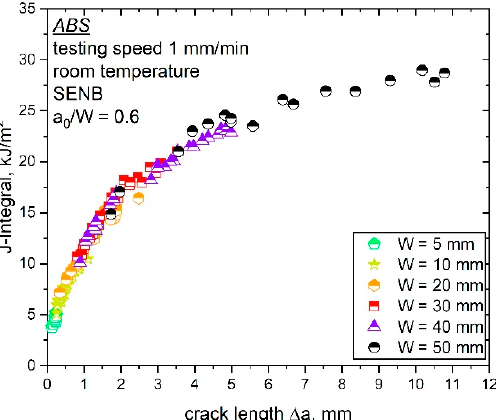
Figure 11. J–R curve for increasing specimen sizes (W is 5, 10, 20, 30, 40 and 50 mm) of ABS as de- termined following the ESIS TC 4 multispecimen procedure (adapted from [7] with